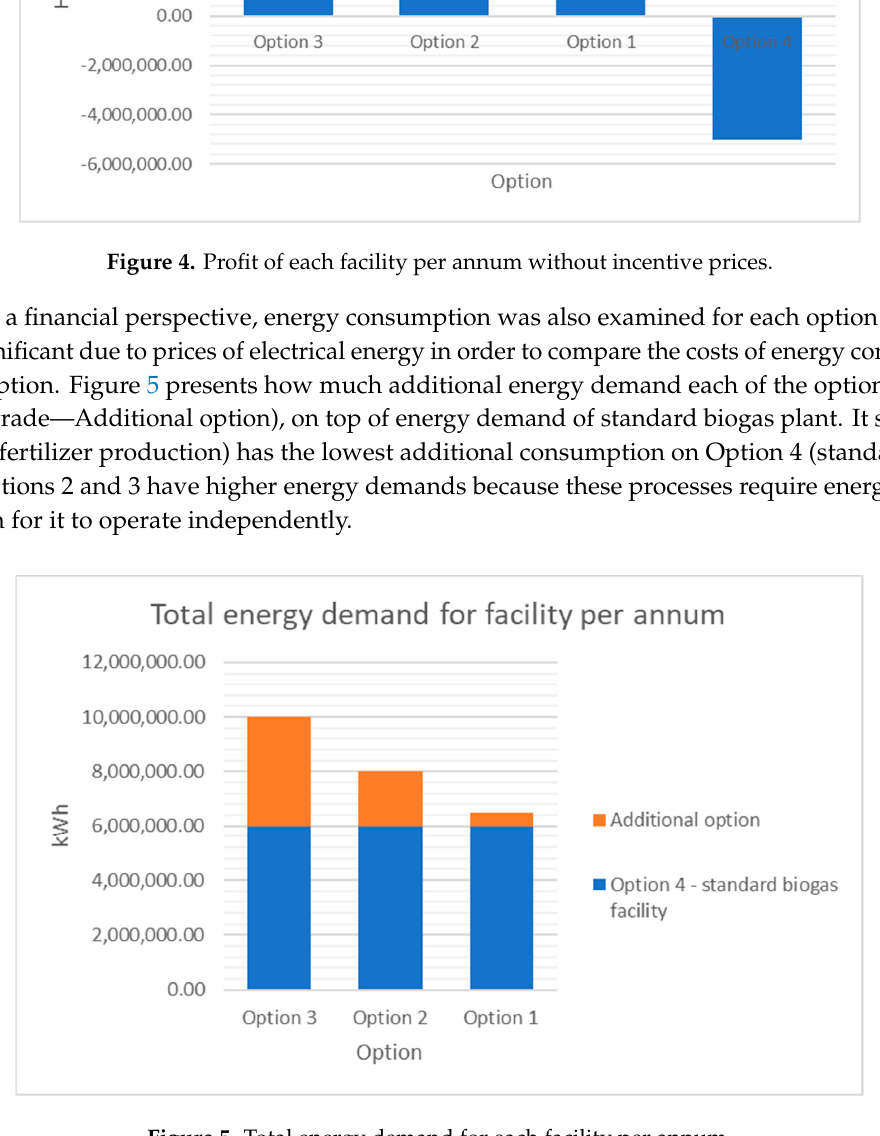
Figure 4. Profit of each facility per annum without incentive prices.